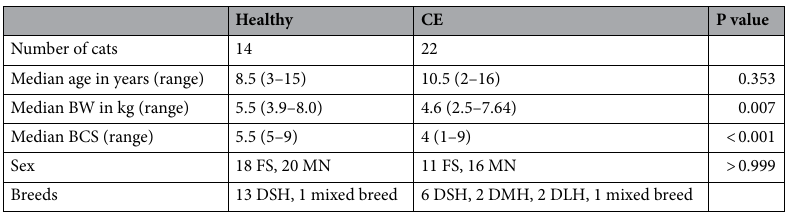
Table 1. Comparison of demographic data between healthy cats and cats with chronic enteropathy (CE). BCS body condition score, 1–4 underweight, 5 ideal, 6–9 overweight, BW body weight, DLH domestic